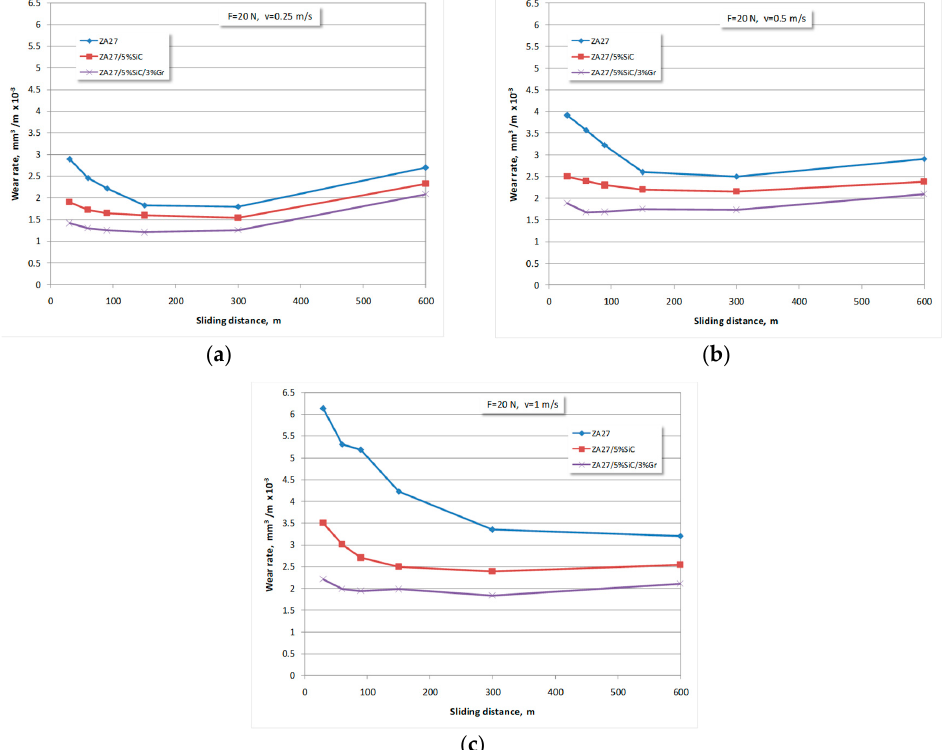
Figure 2. Wear-rate of the tested materials for normal load of 10 N and sliding speed of: ( a ) v = 0.25 m/s; ( b ) v = 0.5 m/s; ( c ) v = 1 m/s. Diagrams of wear-rate obtained for the normal contact load of 20 N and three different sliding speeds are presented in Figure 3a–c.